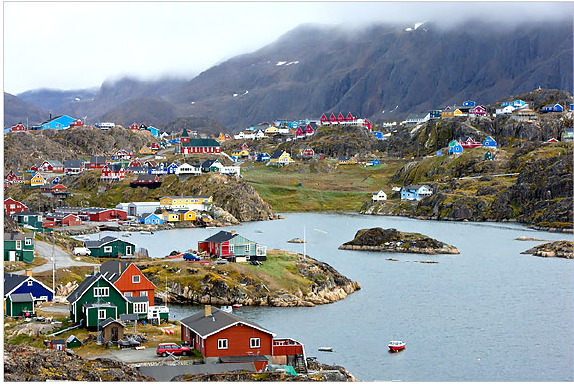
Figure 2: Harbor town Sisimut in Greenland (Ira Block, 2008) Currently, there is a problem in the way of communicating the precise location of an incident to emergency services e.g. the po- lice.